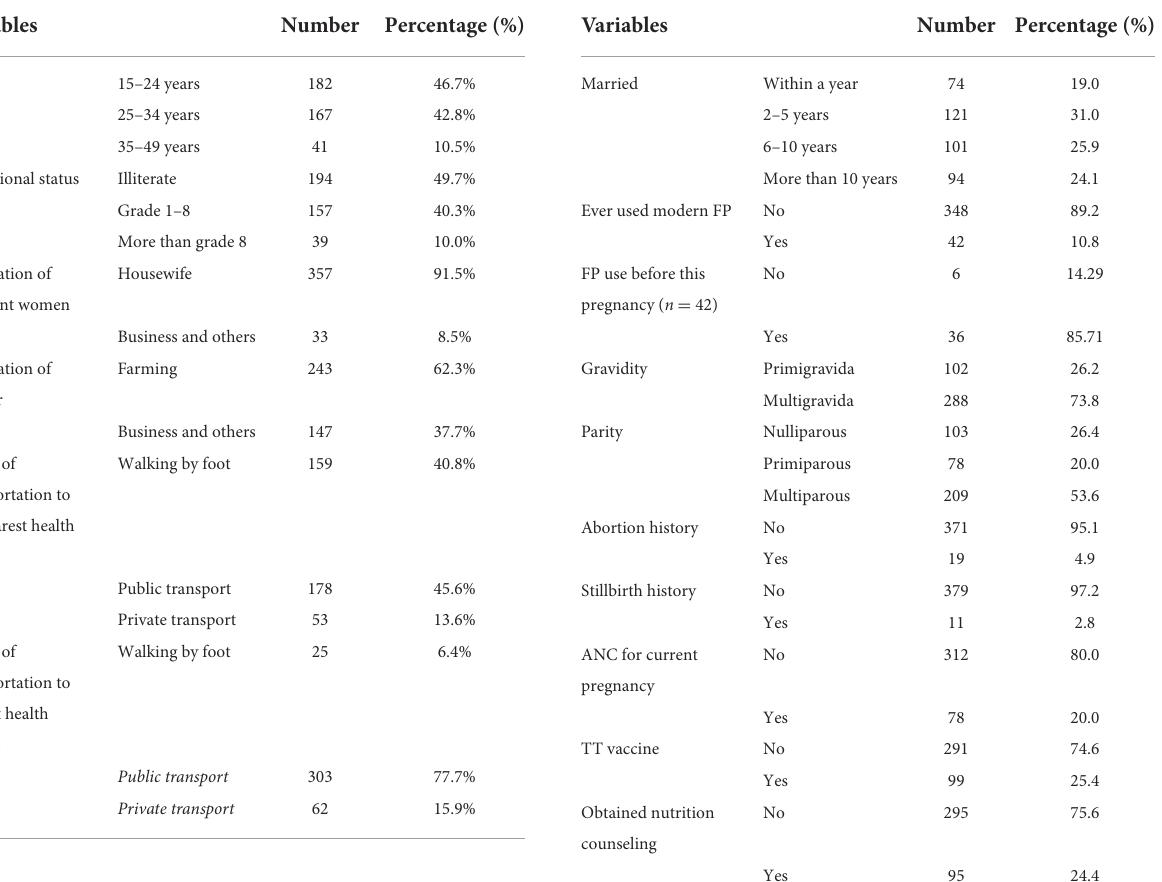
TABLE 2 Obstetric characteristics of currently pregnant women in rural areas of Harari region, eastern Ethiopia,